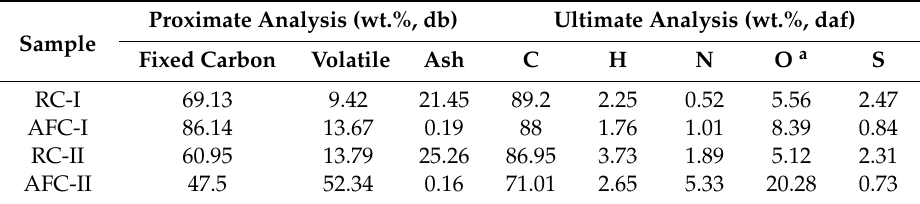
Table 1. Proximate and ultimate analysis of raw coals and ash-free coals. Proximate Analysis (wt.%, Sample